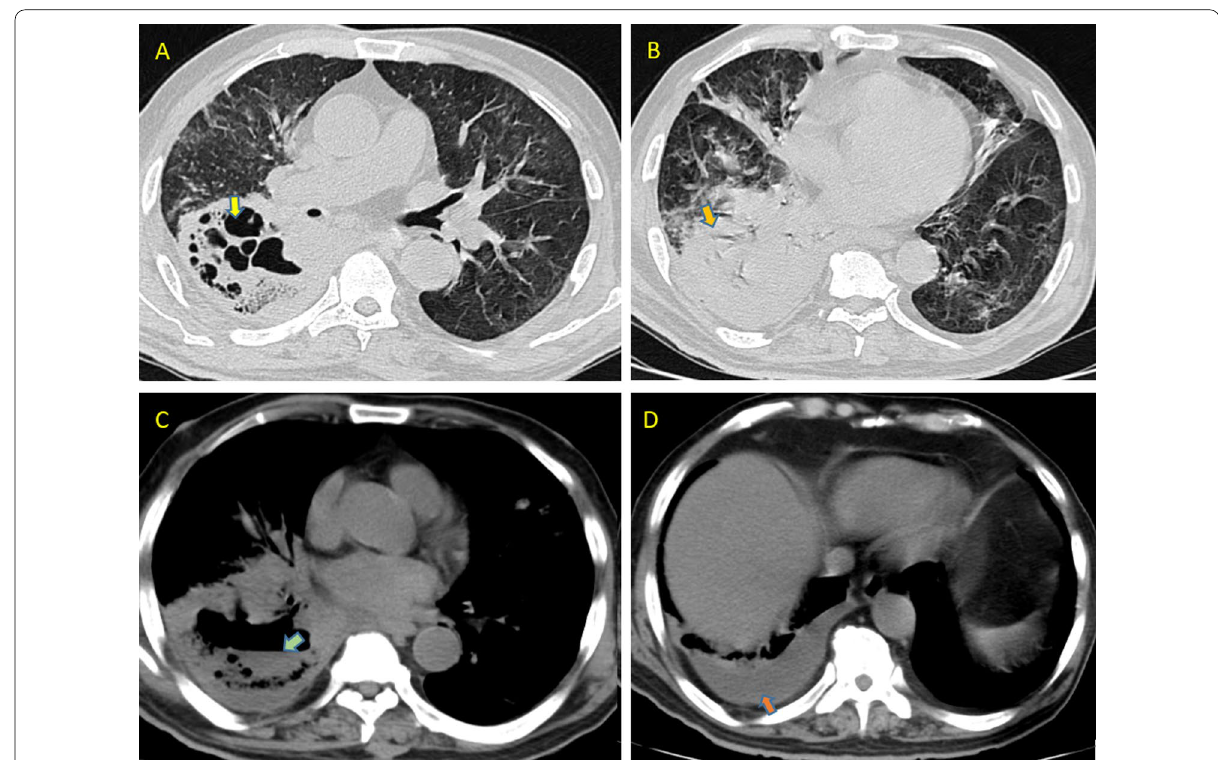
Fig. 4 Axial HRCT scans showing imaging features of Mucormycosis in Case 4 of COVID-19. 4 A , B CT axial image large cavitary lesions (yellow arrow in A ) with thick internal septations, surrounded by thick consolidation. Dense consolidation also noted in left lower lobe (orange arrow in B ). C Air fluid level within cavity (green arrow in C ). D Minimal right pleural effusion (dark orange arrow in D )